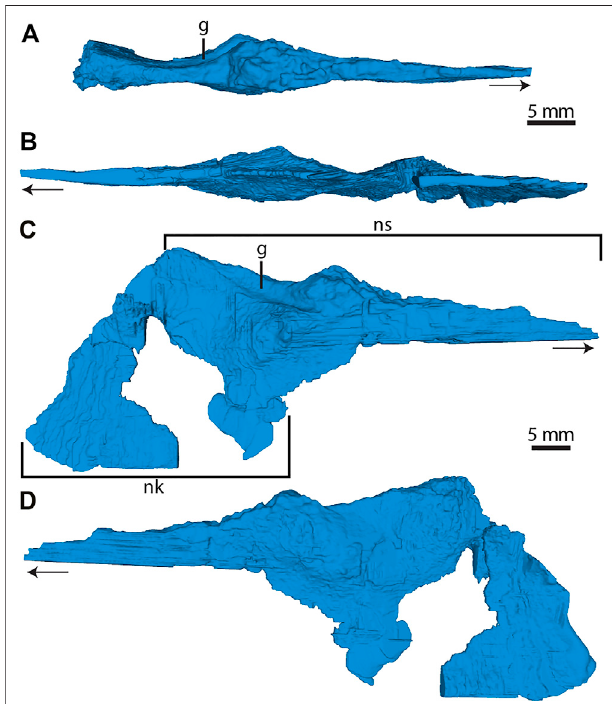
FIGURE 4 | Three-dimensional models of SAMA P40536 vomer. (A) Dorsal view. (B) Ventralview. (C) Right lateral view. (D) Left lateral view. Arrow in (A – D) points towards anterior. Abbreviations: g, posterodorsal groove; nk, nasal keel; ns, nasal septum.